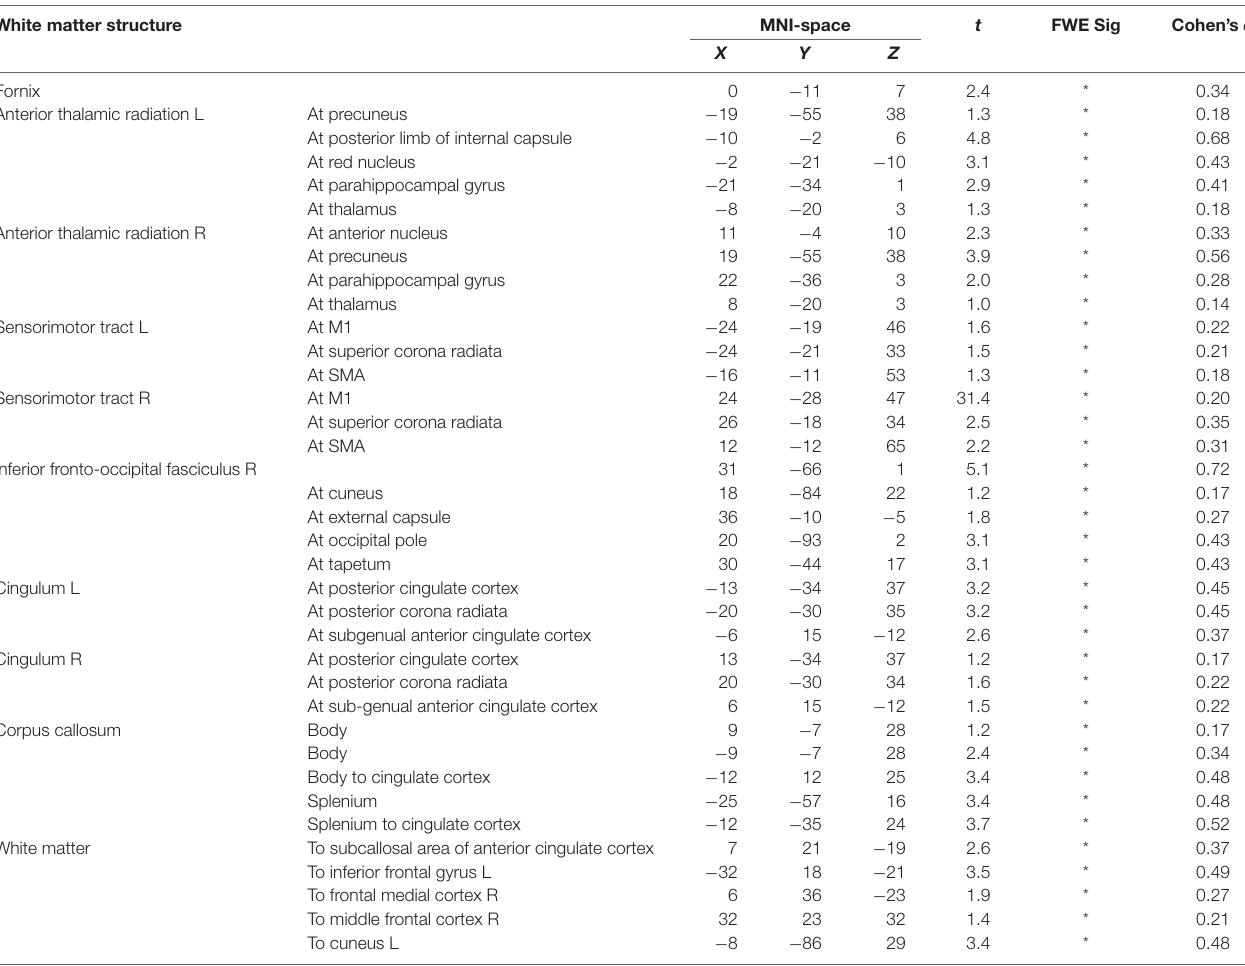
TABLE 4 | Increased FA after the CO-OP intervention in children with DCD a . White matter structure